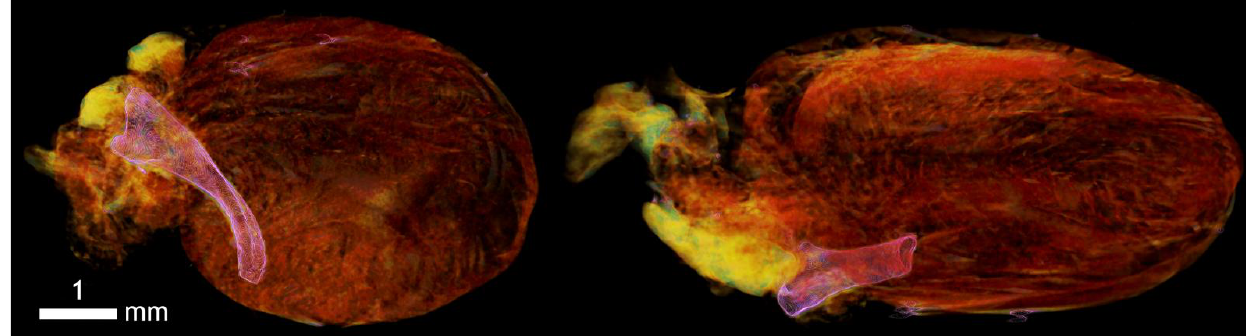
Figure A11. Imaging of superficial vessels of the epicardium and sub fascial layer of the heart.